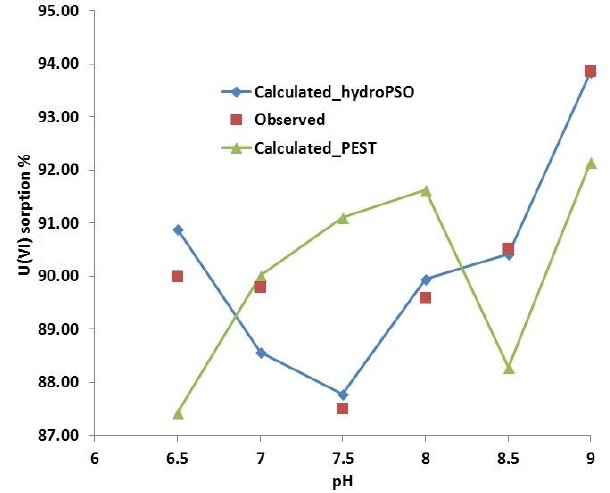
Figure 9. Observed and simulated sorption of uranium in quartz vs. pH with both PEST and hydroPSO calibrated log K